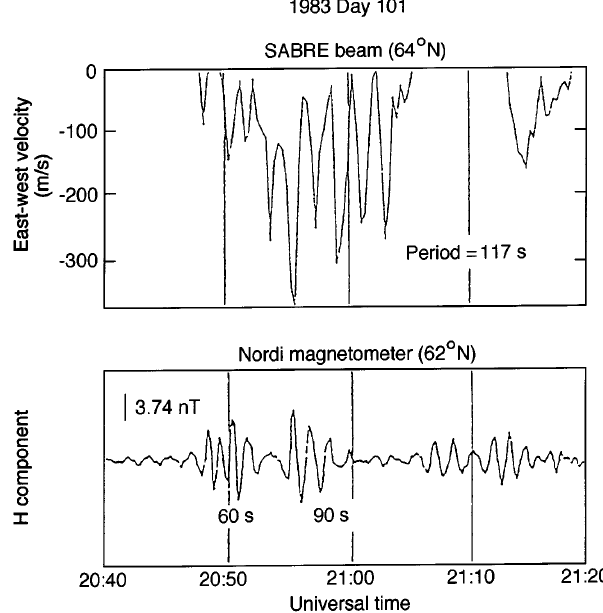
Fig. 10. Simultaneous observations of substorm-associated pulsa- tions by the SABRE radar ( top ) and a ground magnetometer ( bottom ) (adapted from Fig. 6 of Bradshaw and